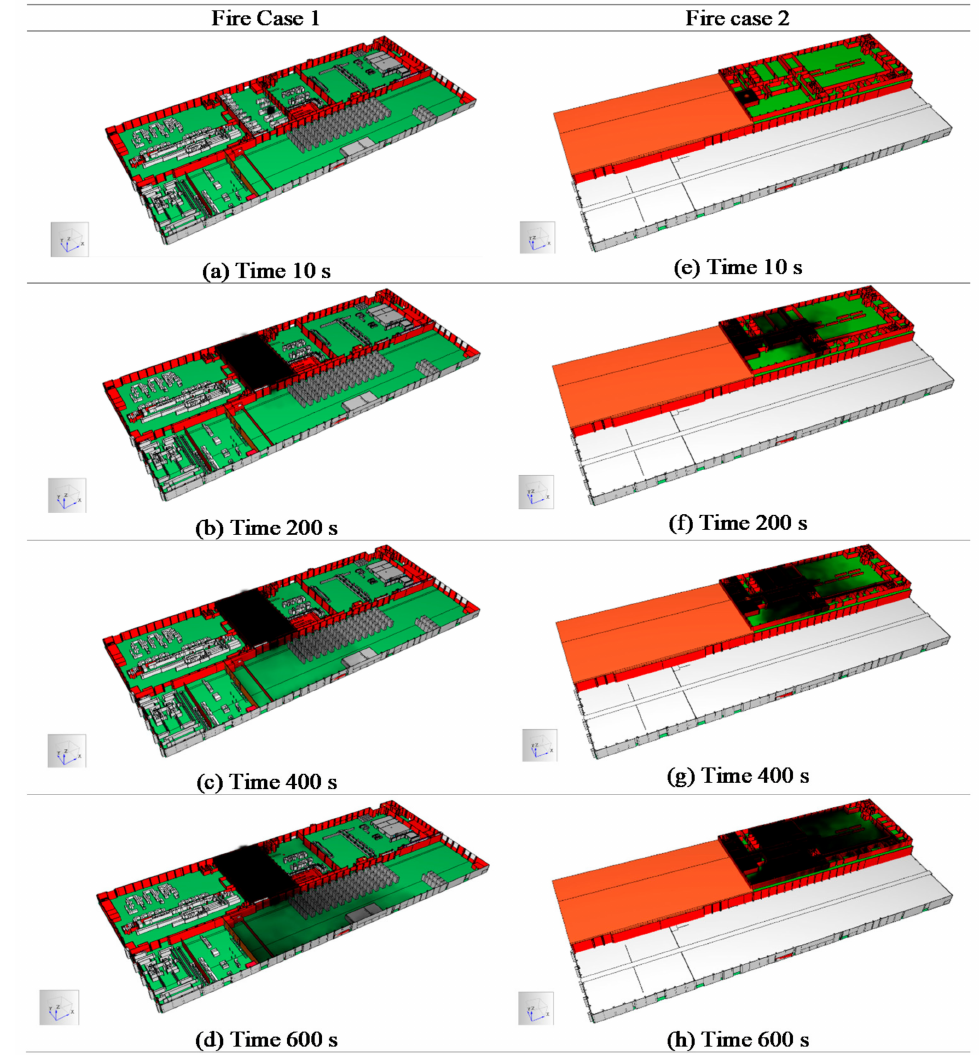
Figure 3. Smoke spread from fire ( a – d ) case 1 and ( e – h ) case